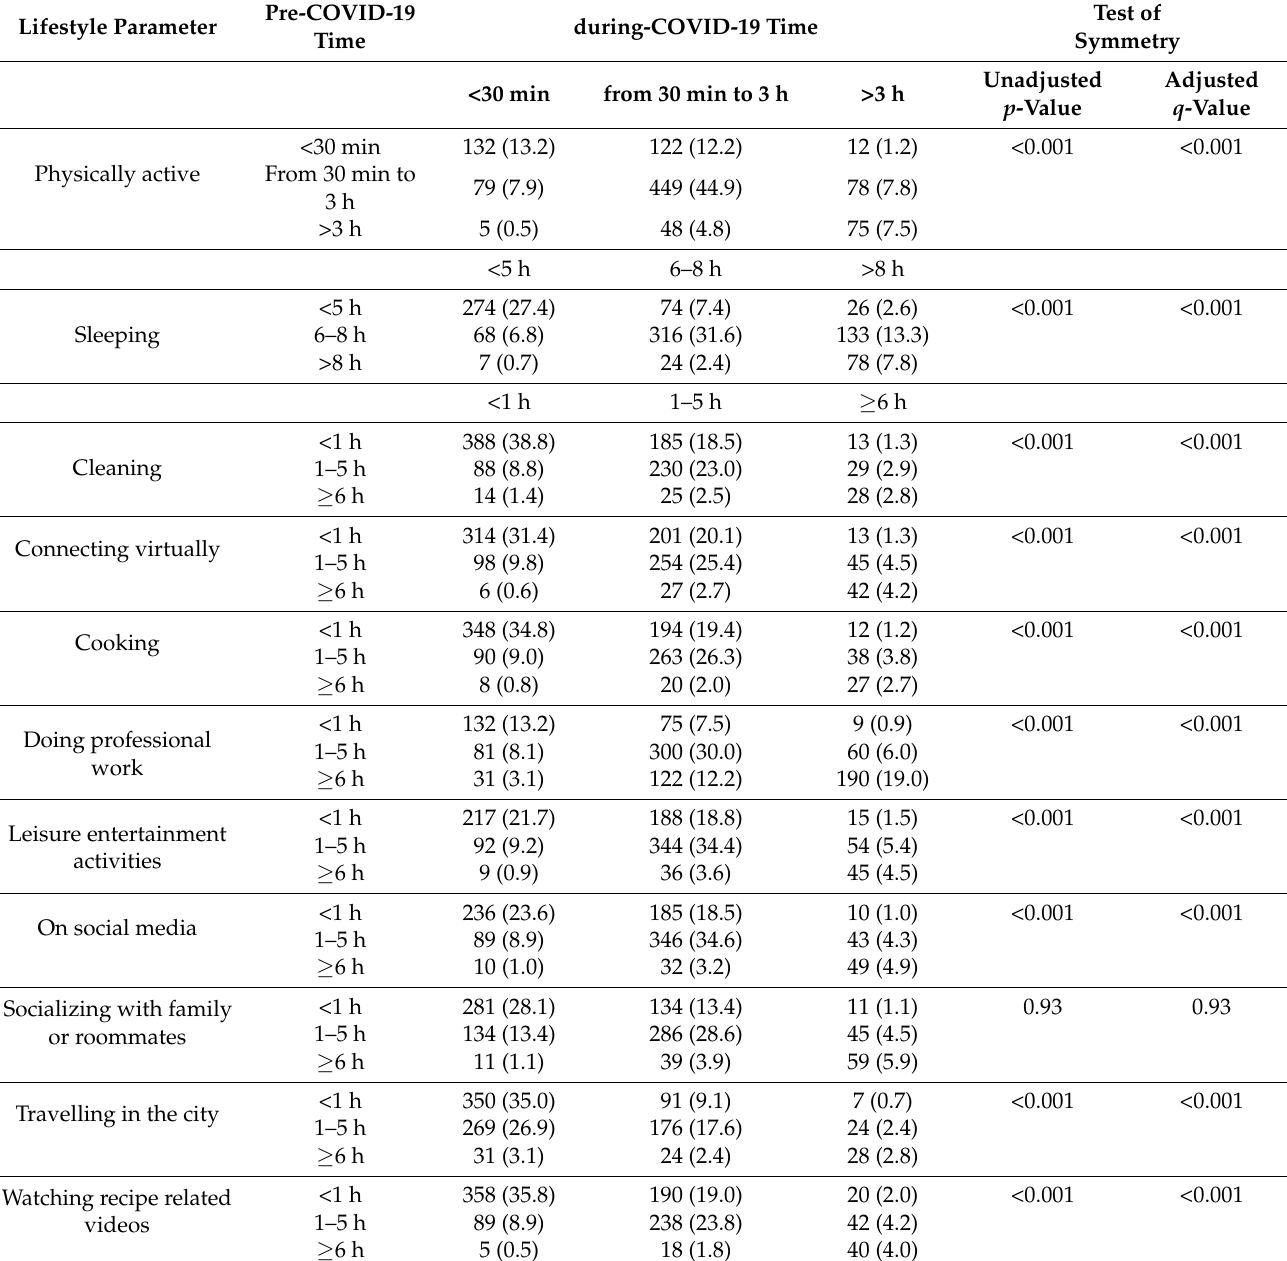
Table 3. The change in self-reported lifestyle behaviors during the COVID-19 confinement compared to pre-COVID-19 *